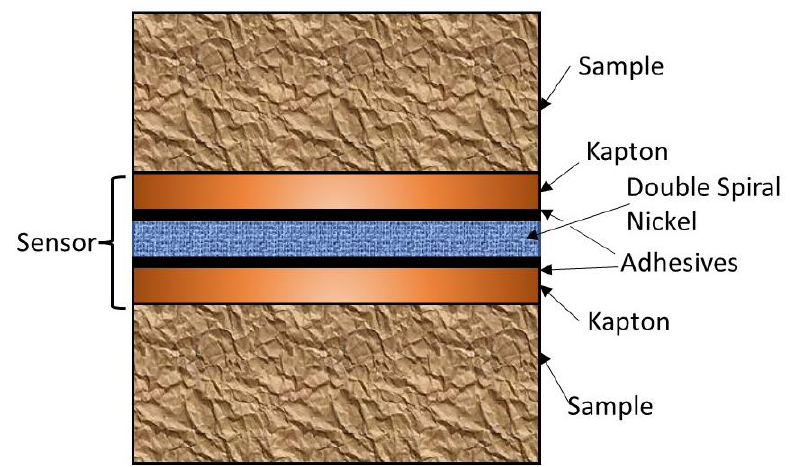
Figure 13. Schematic of the experimental apparatus for the transient plane source method.